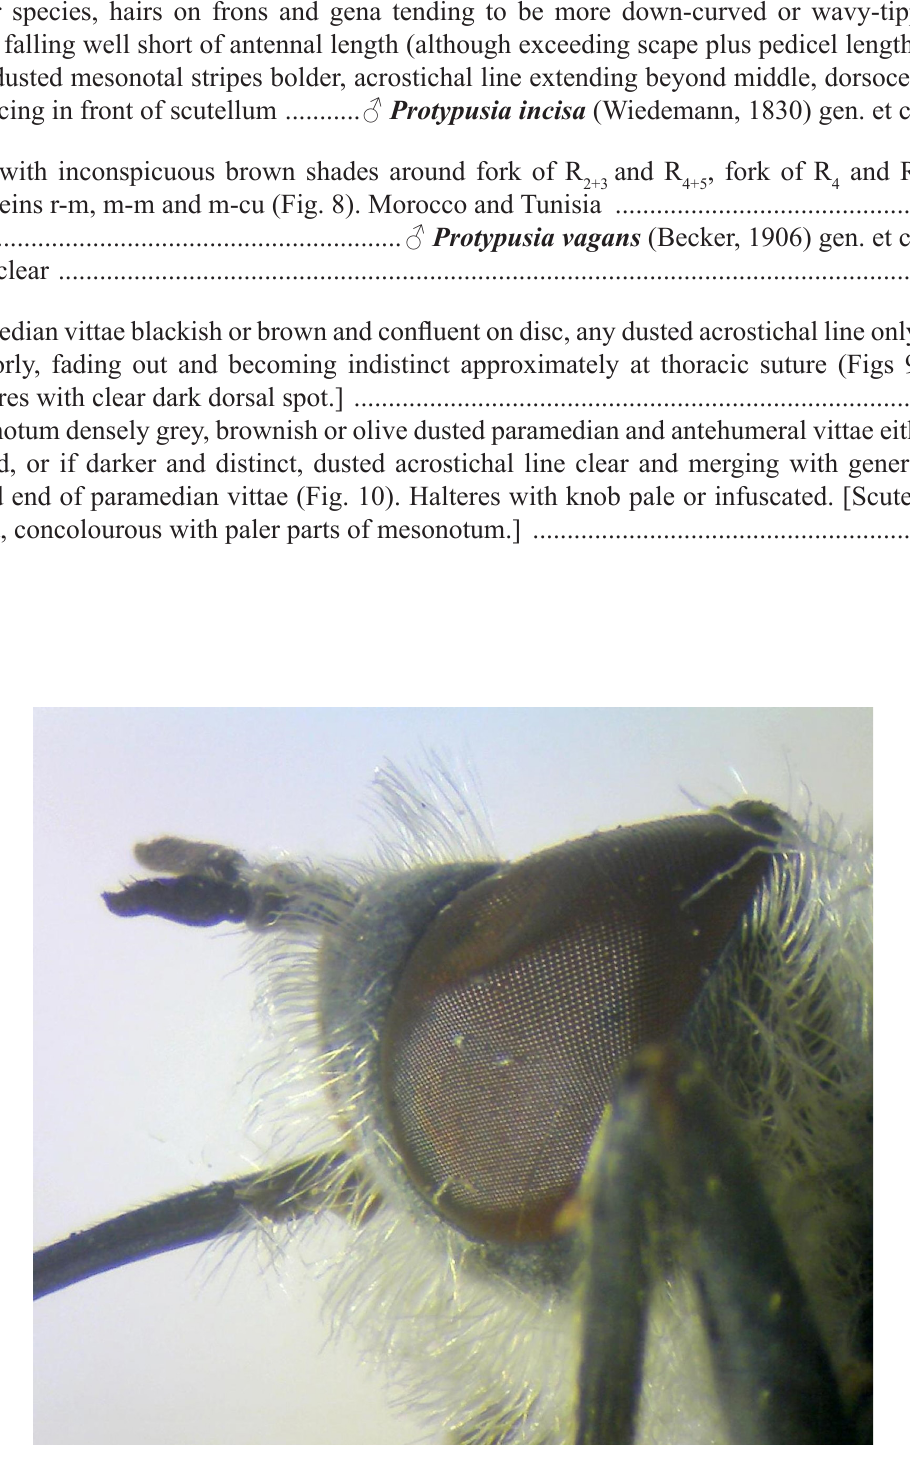
Fig. 7. Protypusia incisa (Wiedemann, 1830) gen. et comb. nov.,